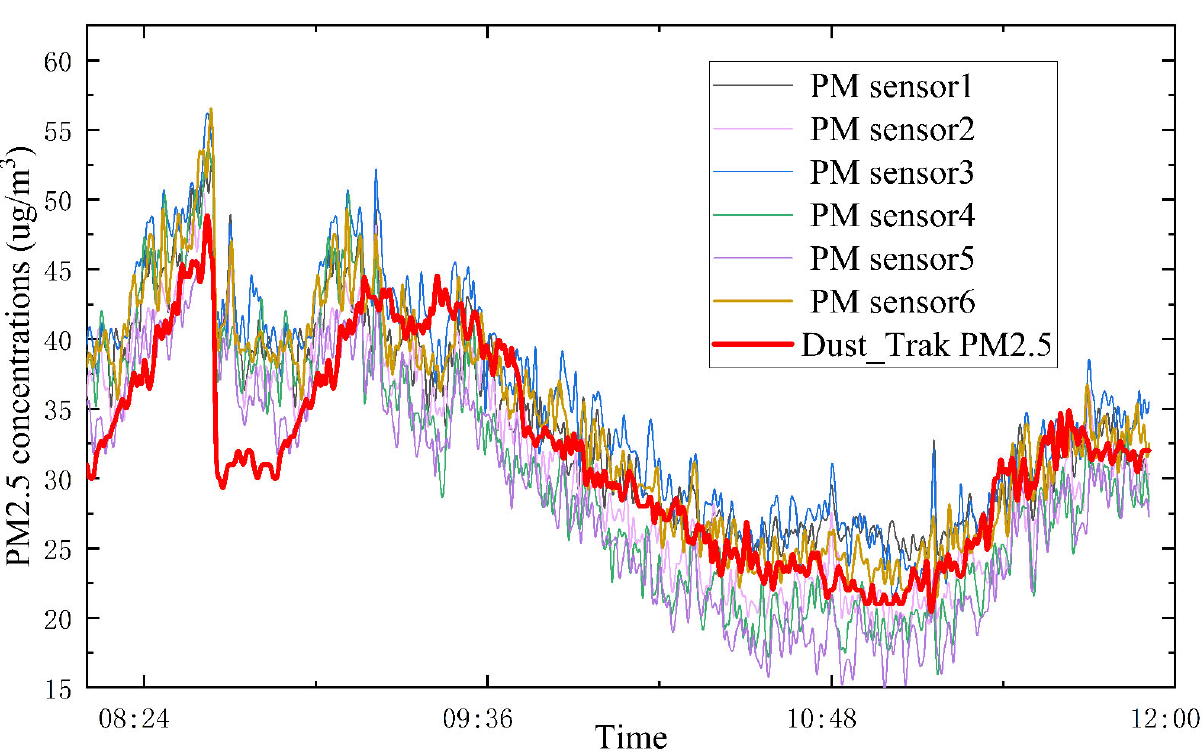
Figure 1. PM 2.5 concentration–time histories recorded by low-cost PM sensors and DustTrak. Figure 1. PM2.5 concentration–time histories recorded by low ‐ cost PM sensors and DustTrak. As shown in Table 1, the average PM 2.5 concentration measured by the DustTrak in the calibration measurement experiment is 31.7 µ g/m 3 , and the PM 2.5 concentration range is 20–49 µ g/m 3 . Among the six PM sensors, the PM sensor 2 is the closest to the data of the DustTrak, with an average relative error of only 11.18%. But the PM 2.5 concentration range of PM sensor 2 is 18–51 µ g/m 3 , which exceeds the PM 2.5 concentration range of the DustTrak, indicating an overestimation or underestimation between the PM sensors and the reference instrument DustTrak. The average relative errors between the six PM sensors and the DustTrak are all kept within 15%, which are consistent with the errors claimed by the manufacturer; but the average relative errors of 3, 4 and 5 are all over 14%. The PM